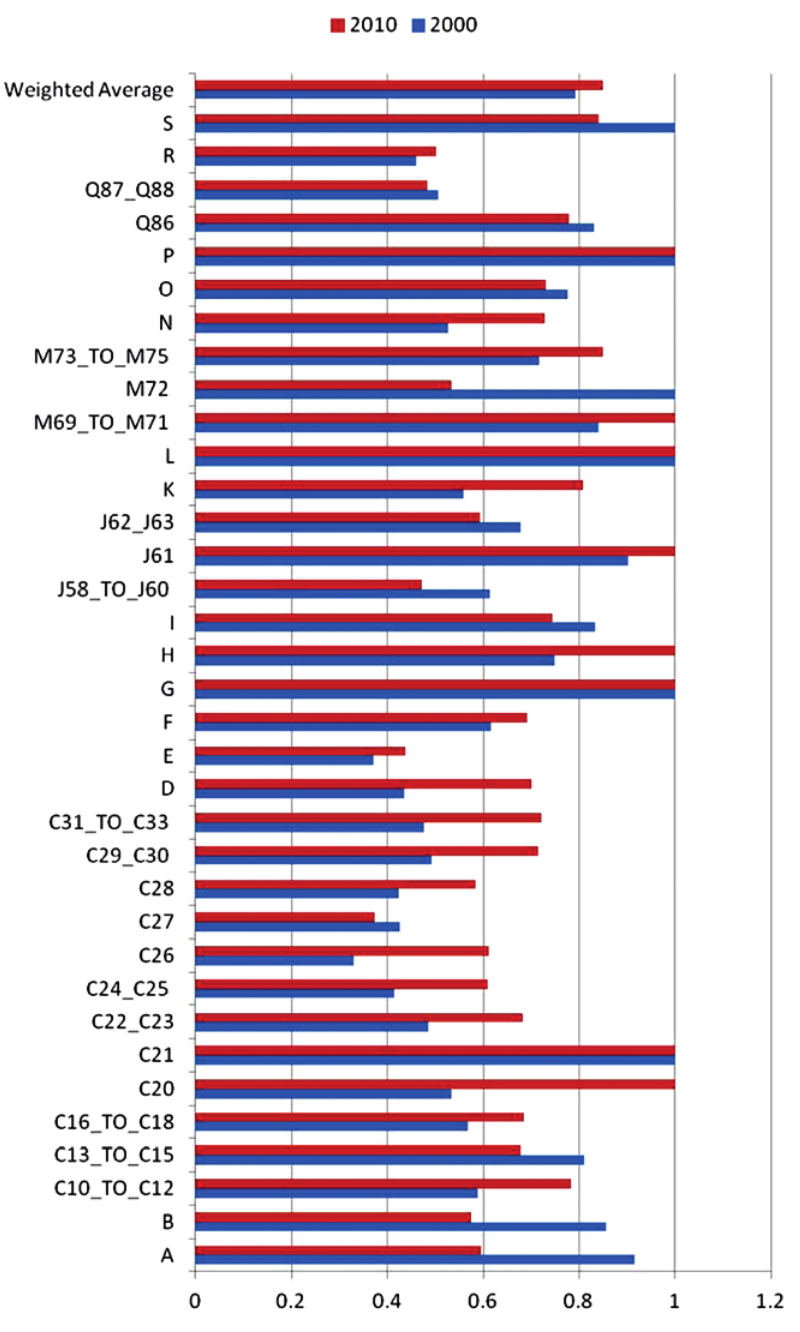
Fig. 2. Technical efficiency scores across economic sectors, 2000 and 2010 Note: see Table A1 in Appendix A for